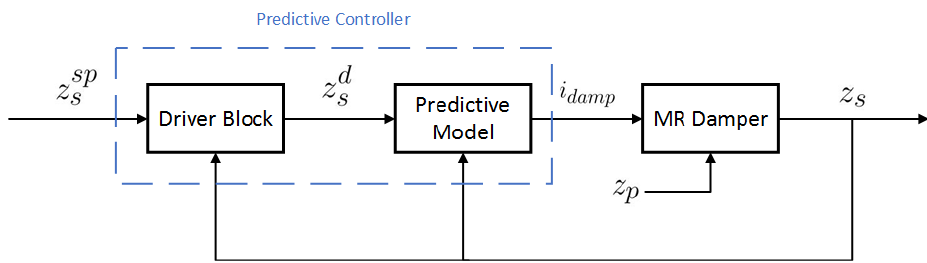
Figure 2. Predictive control strategy for a one-quarter semi-active vehicle